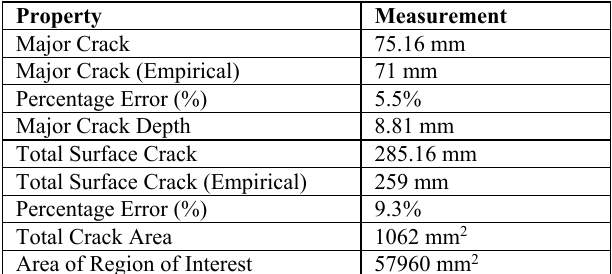
Table 4. Results of CDM